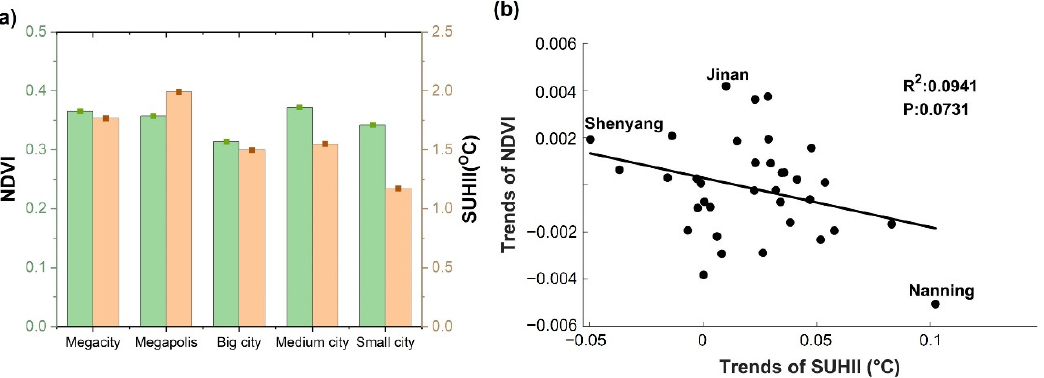
Figure 9. ( a ) Comparison of NDVI and SUHII in five categories; ( b ) Linear regression relationships between the trends of SUHII and the trends of NDVI across 35 cities during 2000–2020. Each dot represents a city.